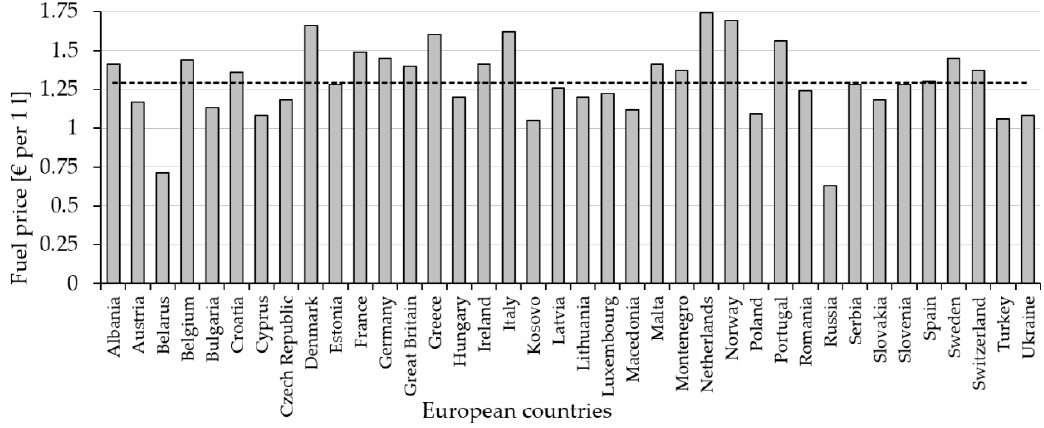
Figure 13. The price of gasoline in selected European countries as of 10 January 2020.